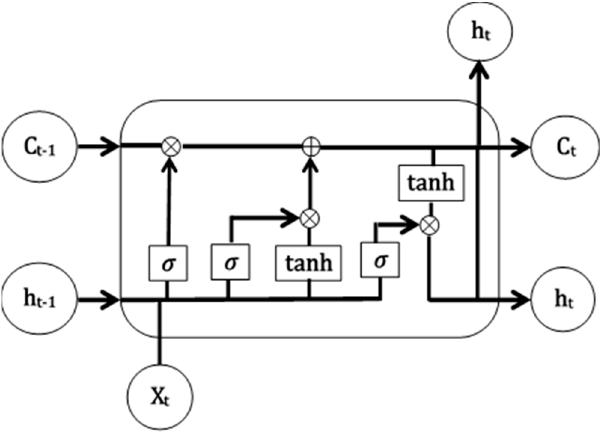
Figure 5. Long short-term memory (LSTM) architecture.